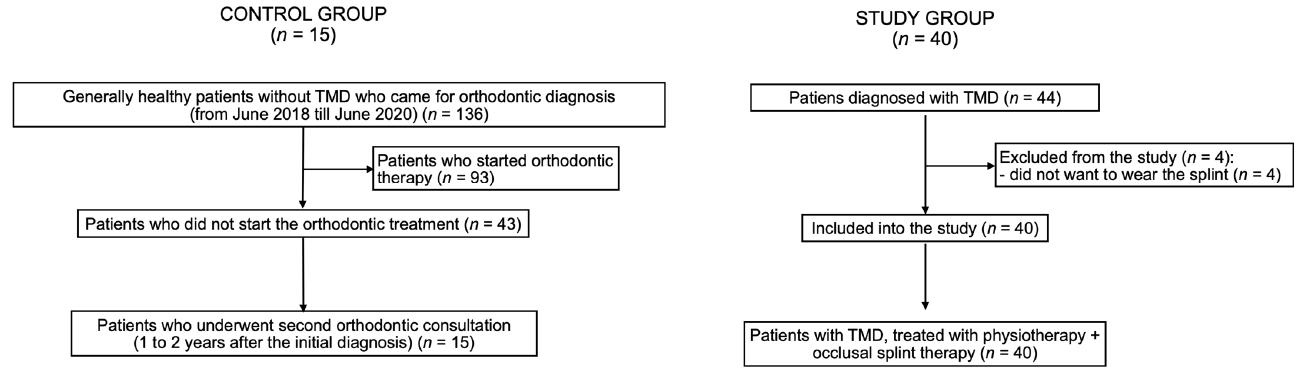
Table 2. T he comparison of the examined parameters regarding the hyoid bone position and the width of nasopharynx and oropharynx during the initial examination between study group and control group.